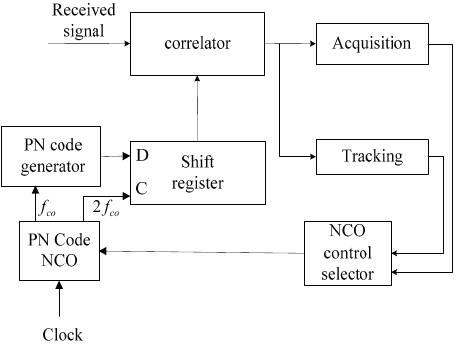
Figure 5. Block diagram of the code synchronization